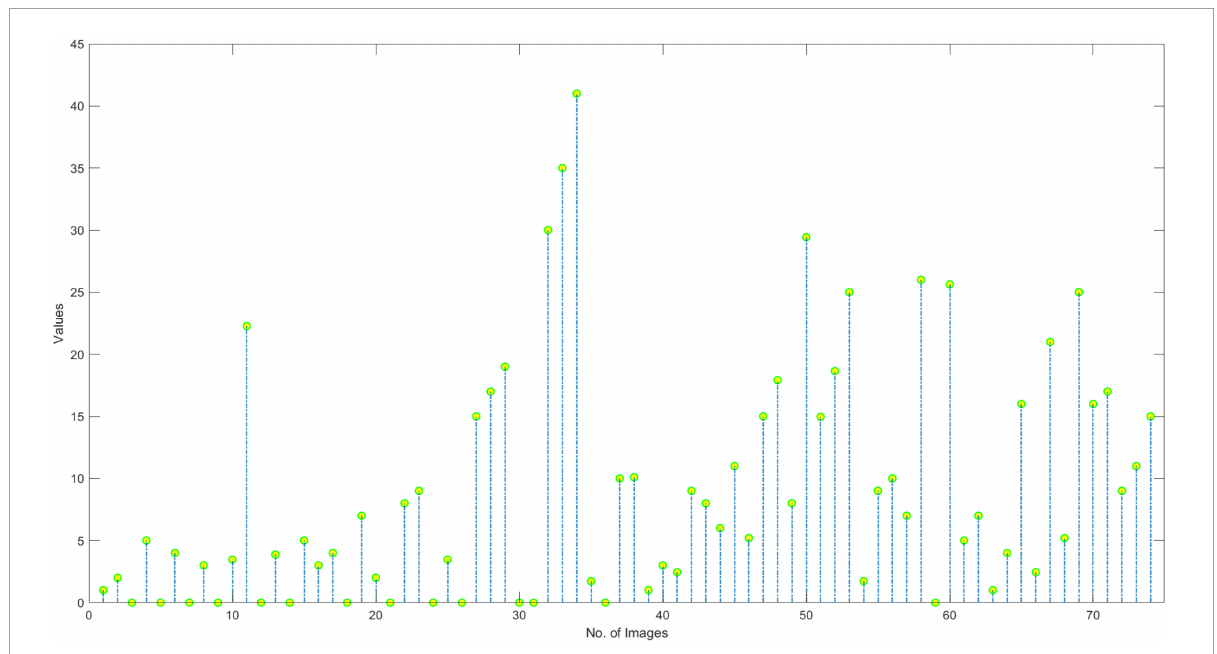
FIGURE14 Similarity with PMI class.